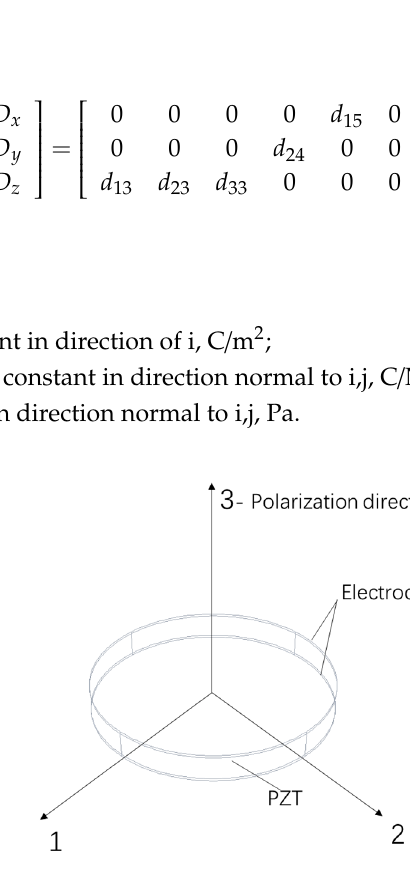
Figure 1. The circular piezoelectric patch of d 33 mode.